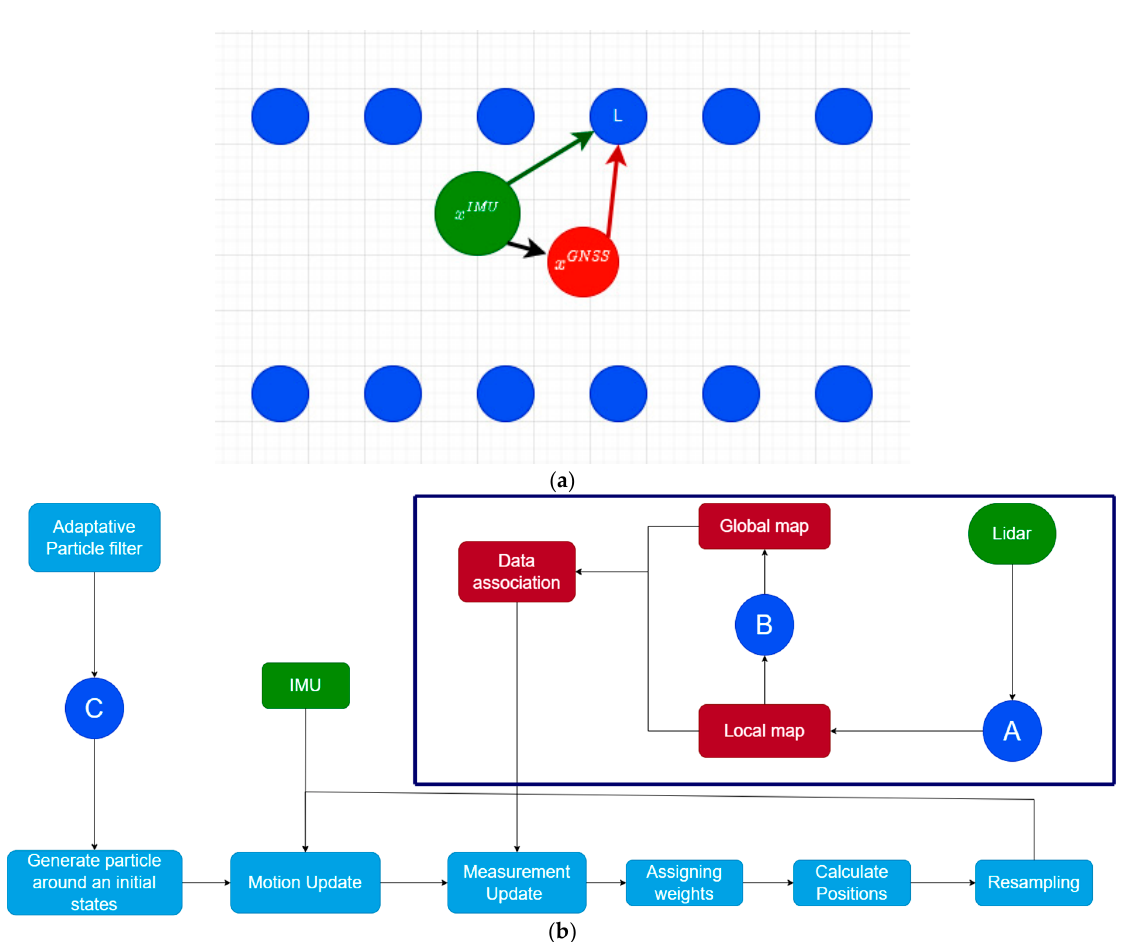
Figure 1. Workflow architecture describing our proposed method. ( a ): Describing the vehicles true position (in red), IMU’s position (in blue) and objects in the vehicles environment as picked up by the LiDAR (in blue). ( b ): The structure of the proposed approach consists of two main steps: data processing {features extraction (A) + global mapping (B)}, described within the dark blue rectangle, which is a framework for LiDAR measurements processing and creating local and global maps. Secondly, localization (C) using adaptive particle filters.